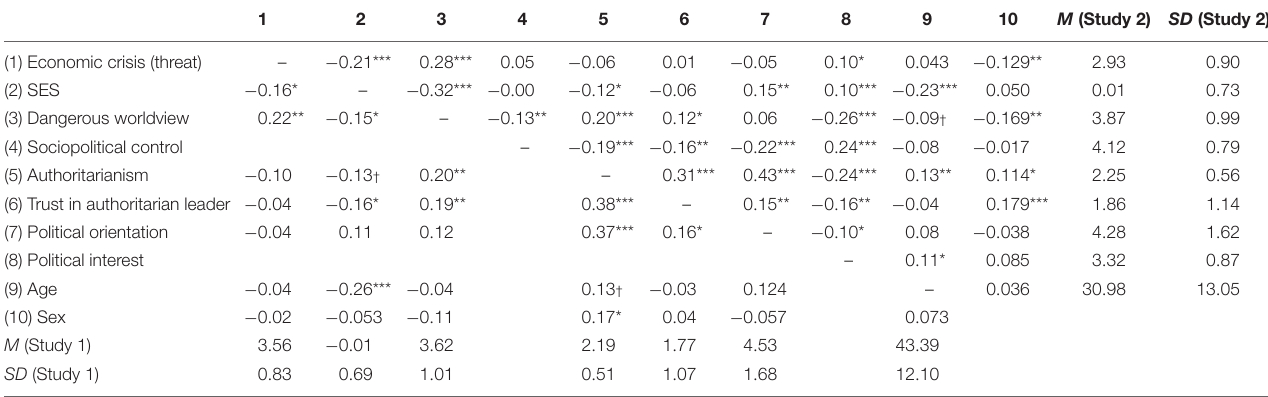
TABLE 2 | Descriptive statistics (means and standard deviations) and bivariate correlations between the variables included in Study 1 (below the diagonal) and Study 2 (above the